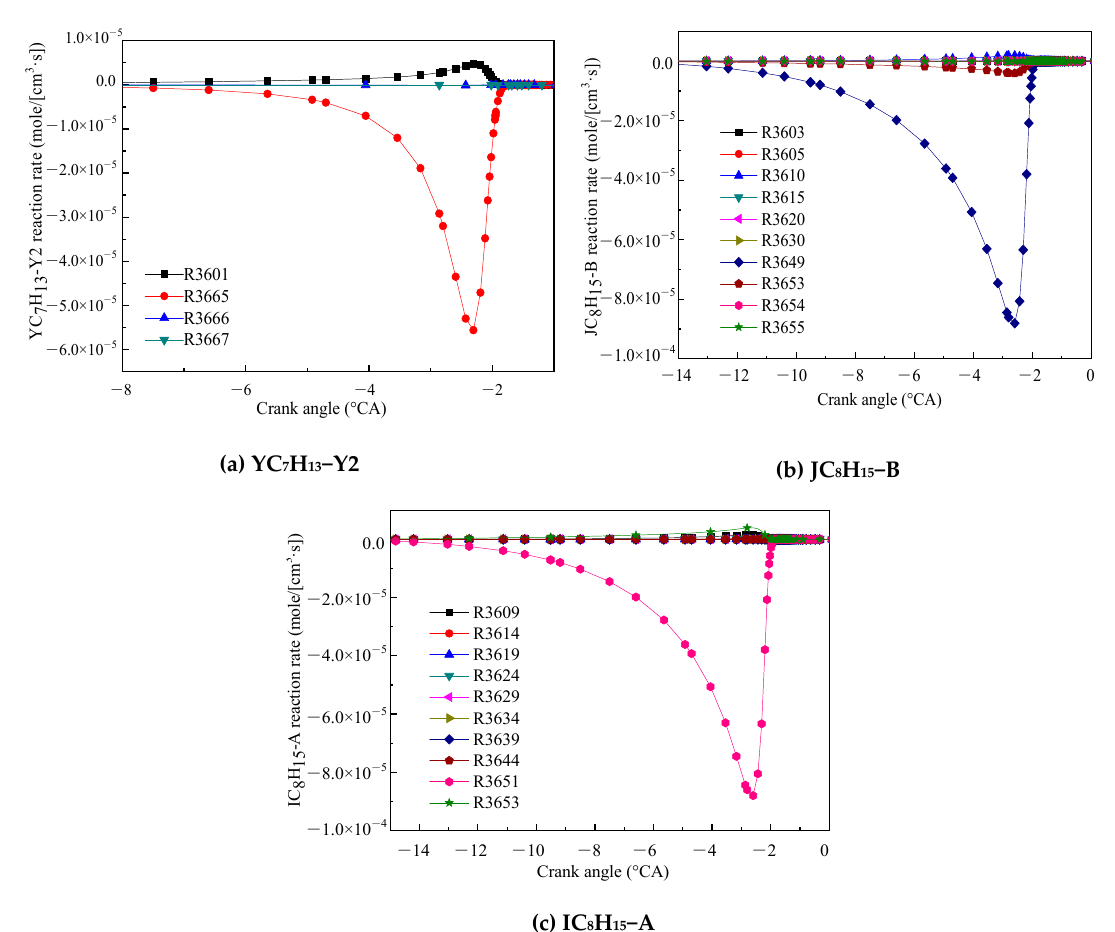
Figure 3. Reaction rates of the main reactions of the three products YC 7 H 13 − Y2 ( a ), JC 8 H 15 − B ( b ) and IC 8 H 15 − A ( c ).